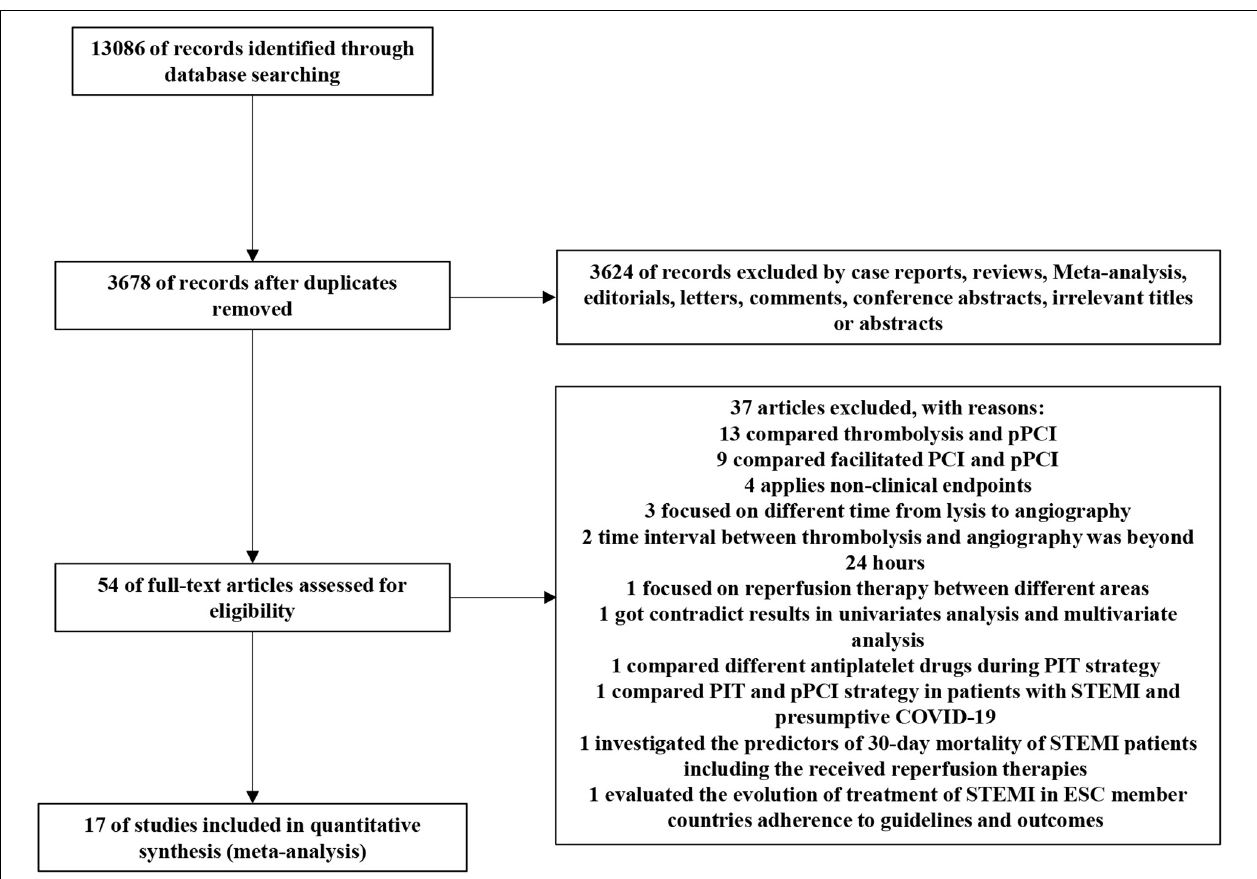
FIGURE 1 | PRISMA flow chart of the selection strategy. PCI, percutaneous coronary intervention; pPCI, primary percutaneous coronary intervention; STEMI, ST-elevation myocardial infarction; COVID-19, Corona Virus Disease 2019; ESC, European Society of